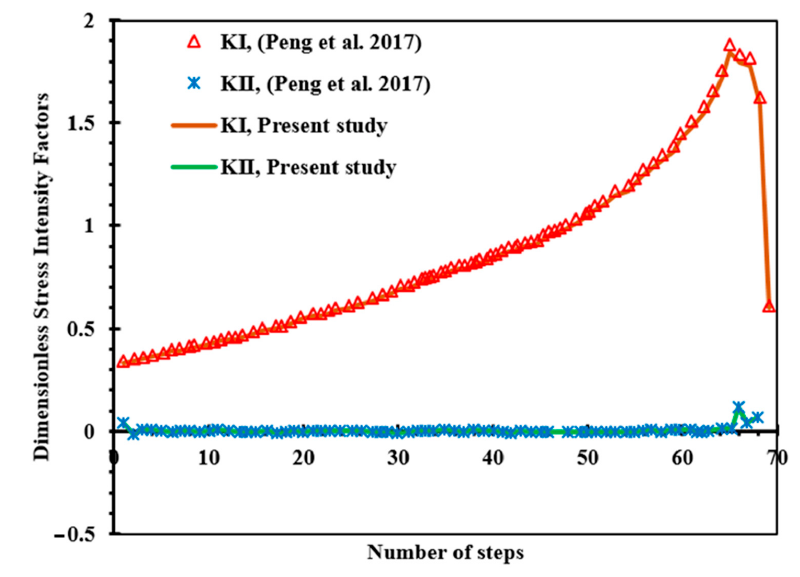
Figure 15. Comparison of the dimensionless stress intensity factors for case II for the PMMA speci- men.